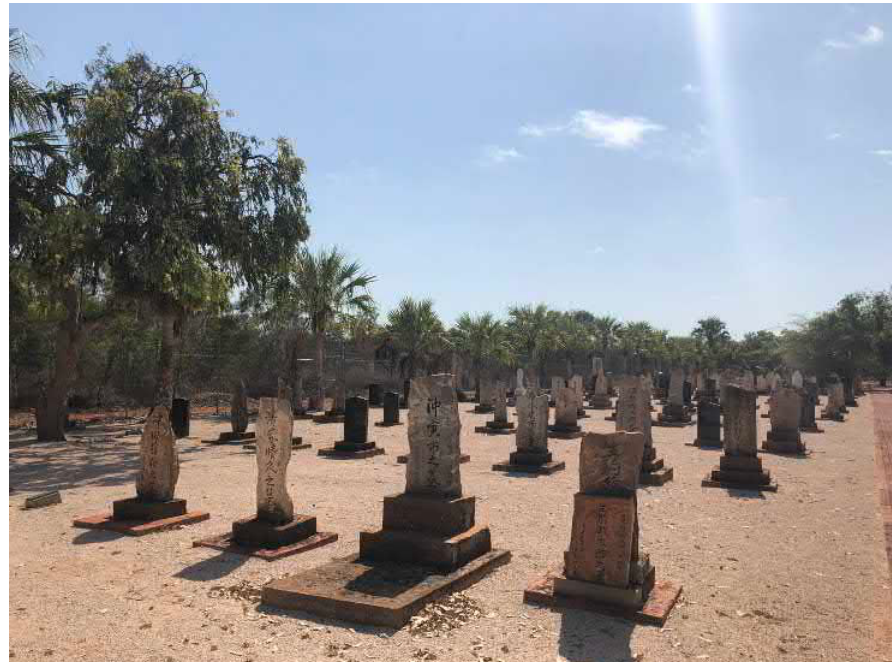
Figure 10: Broome Cemetery. (Photo: Anna